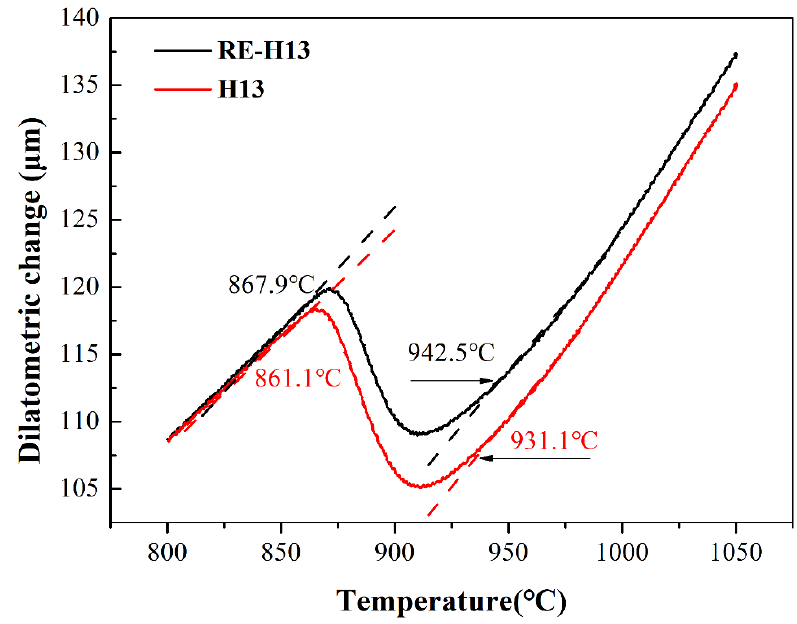
Figure 6. Thermal expansion curves of the tested steels after annealing.